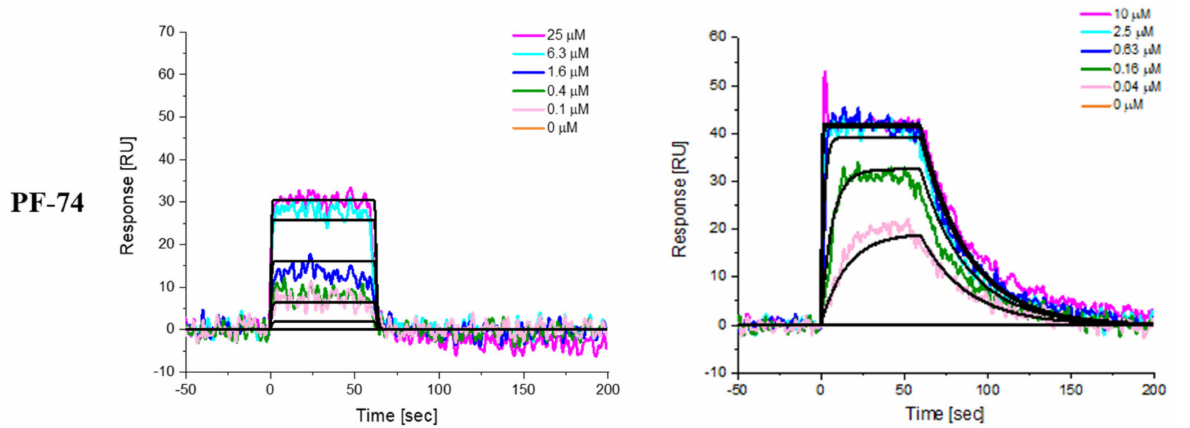
Figure 3. Representative sensorgrams depicting the interaction of I-19 and PF-74 with the HIV-1 CA monomer and hexamer. SPR sensorgrams showing (Left Panel) I-19 and PF-74 (25 µ M starting concentration with 1:4 serial dilutions) binding to immobilized NL4-3 CA monomer, (Right Panel) I-19 and PF-74 (100 µ M starting concentration with 1:5 serial dilutions for I-19 and 10 µ M starting concentration with 1:4 serial dilutions for PF-74 ) binding to immobilized disulfide-stabilized NL4-3 CA hexamer. Colored lines represent actual data collected from the dilution series, whereas black lines signify the fits to a 1:1 binding